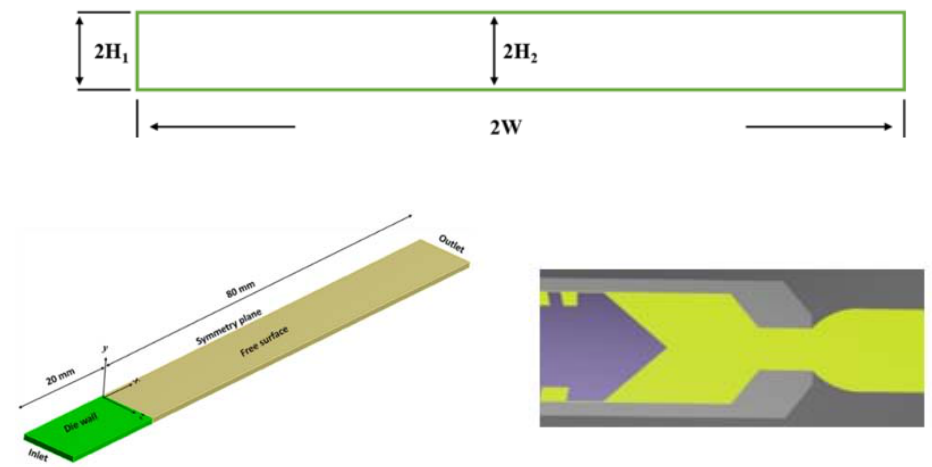
Figure 1. Top : the cross section of a slit die, considering the case of an aspect ratio of 10. Four swell ratios are defined, as mathematically represented by Equations (1) and (2) They relate to swelling for the width direction, the edge height direction, the middle height direction, and the area swelling; Bottom left : 3D flow domain of a slit die profile for the isothermal (200 °C) flow simulations; one quarter of the geometry is considered; Bottom right : conceptual visualization of die swell; focus on one direction only.